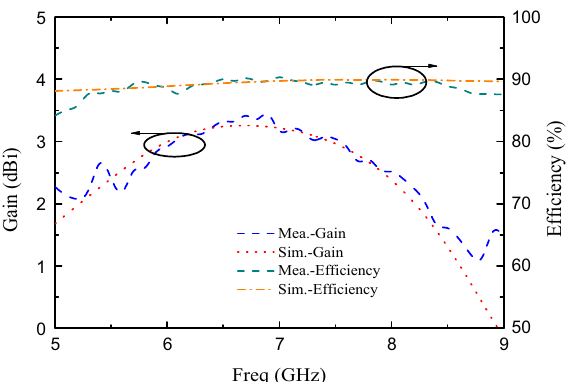
Fig. 12 Measured curves of the proposed UWB circularly polarized antenna gain. The simulation results are also included for the